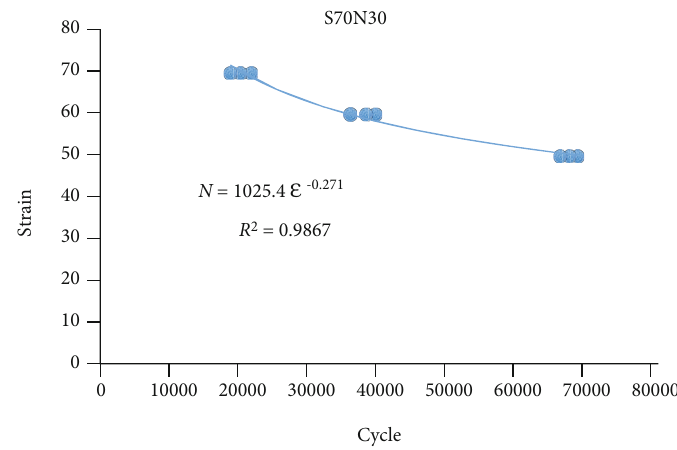
Figure 3: Fitted curve error in the strain-life diagram of S70N30 compound.